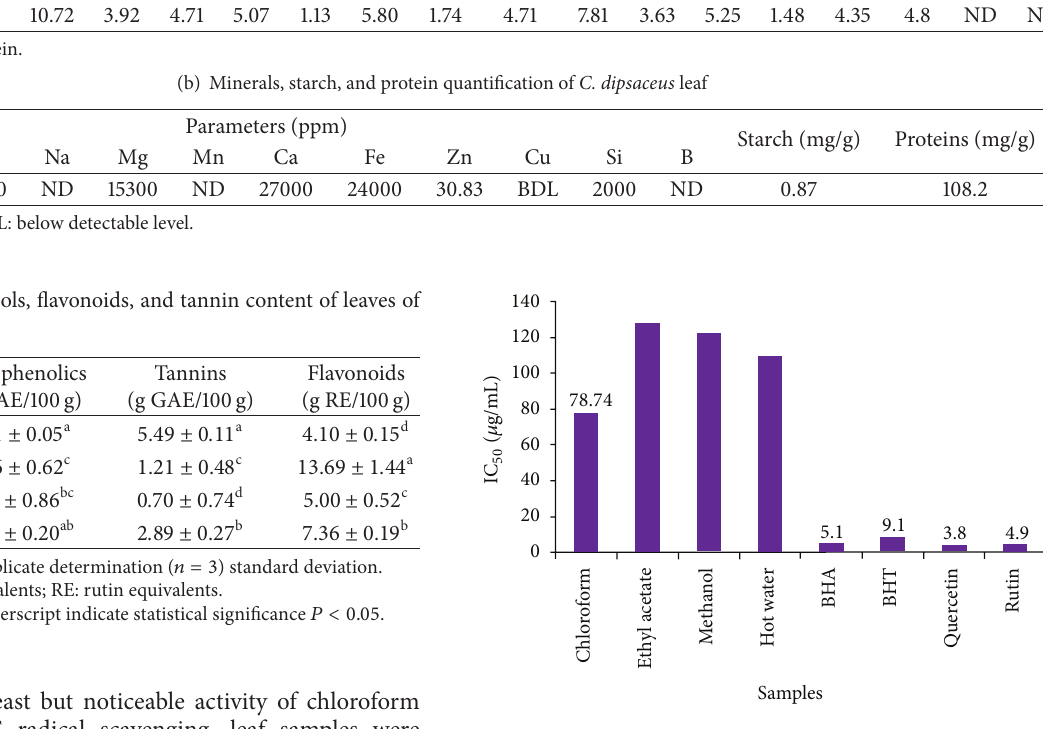
Figure 1: DPPH radical scavenging activity of leaf and fruit extract of C. dipsaceus . Values are mean of triplicate determination (𝑛 = 3) ± standard